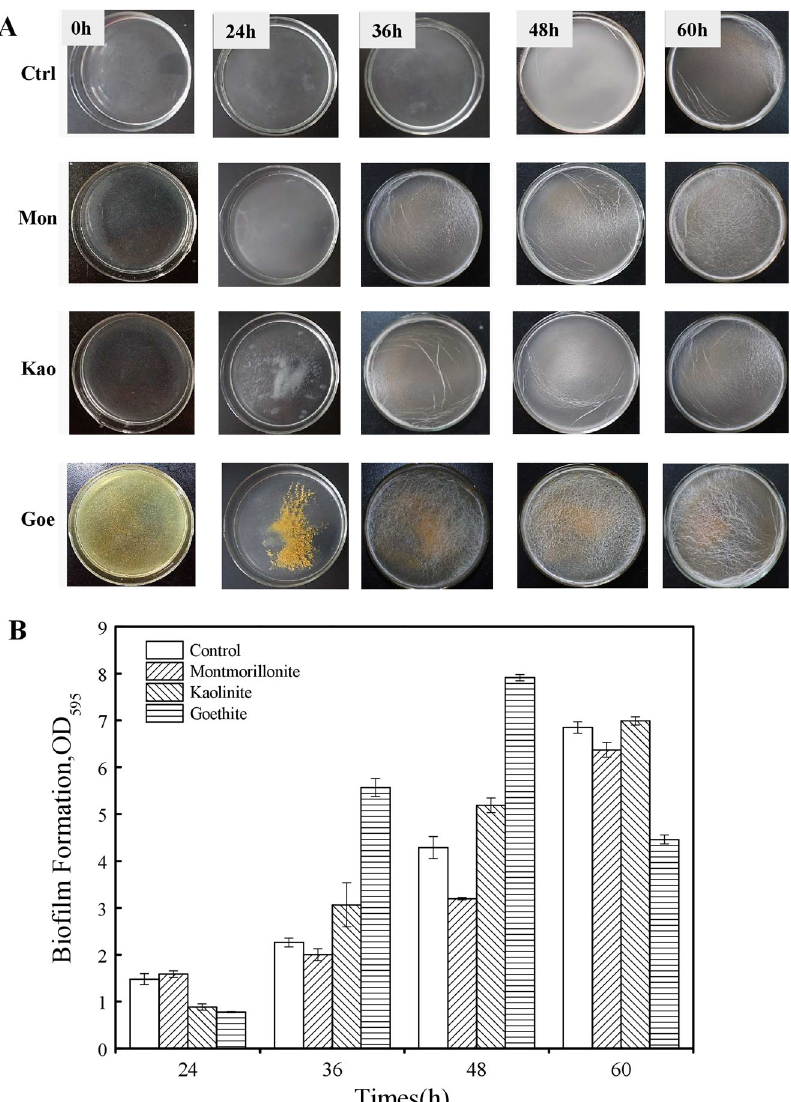
Fig. 1 Bio fi lm formation of B. subtilis at differernt time intervals in supplement with different clay minerals. a Pellicles with wrinkles were showed for control (Ctrl), montmorillonite (Mon), kaolinite (Kao), and goethite (Goe) at 0, 24, 36, 48, and 60 h as indicated on the left/top, respectively. b Quantitive assessment of bio fi lm formation as determined by crystal violet